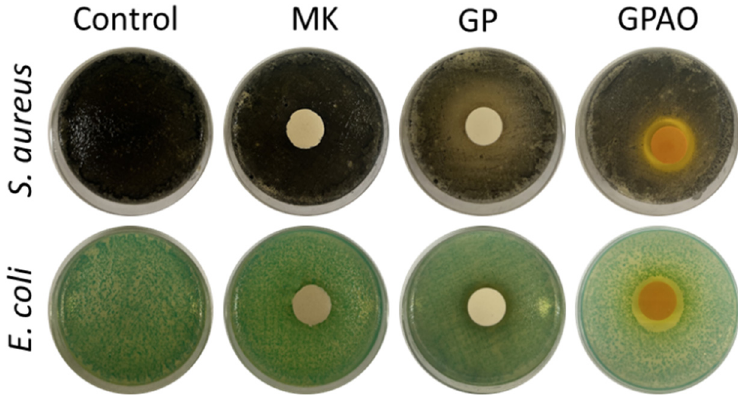
Figure 8. Sample images after the incubation with the bacterial strains.